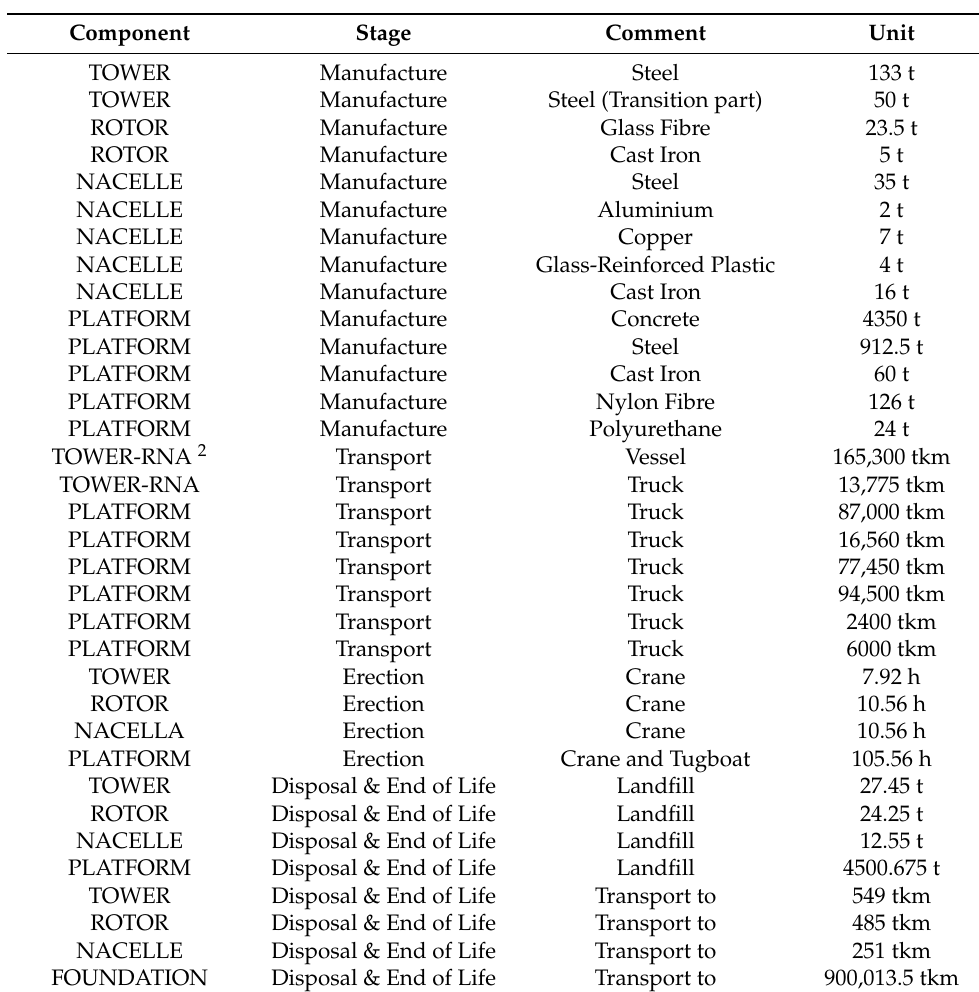
Table 4. Data collection—life cycle inventory [11,33,43,44].